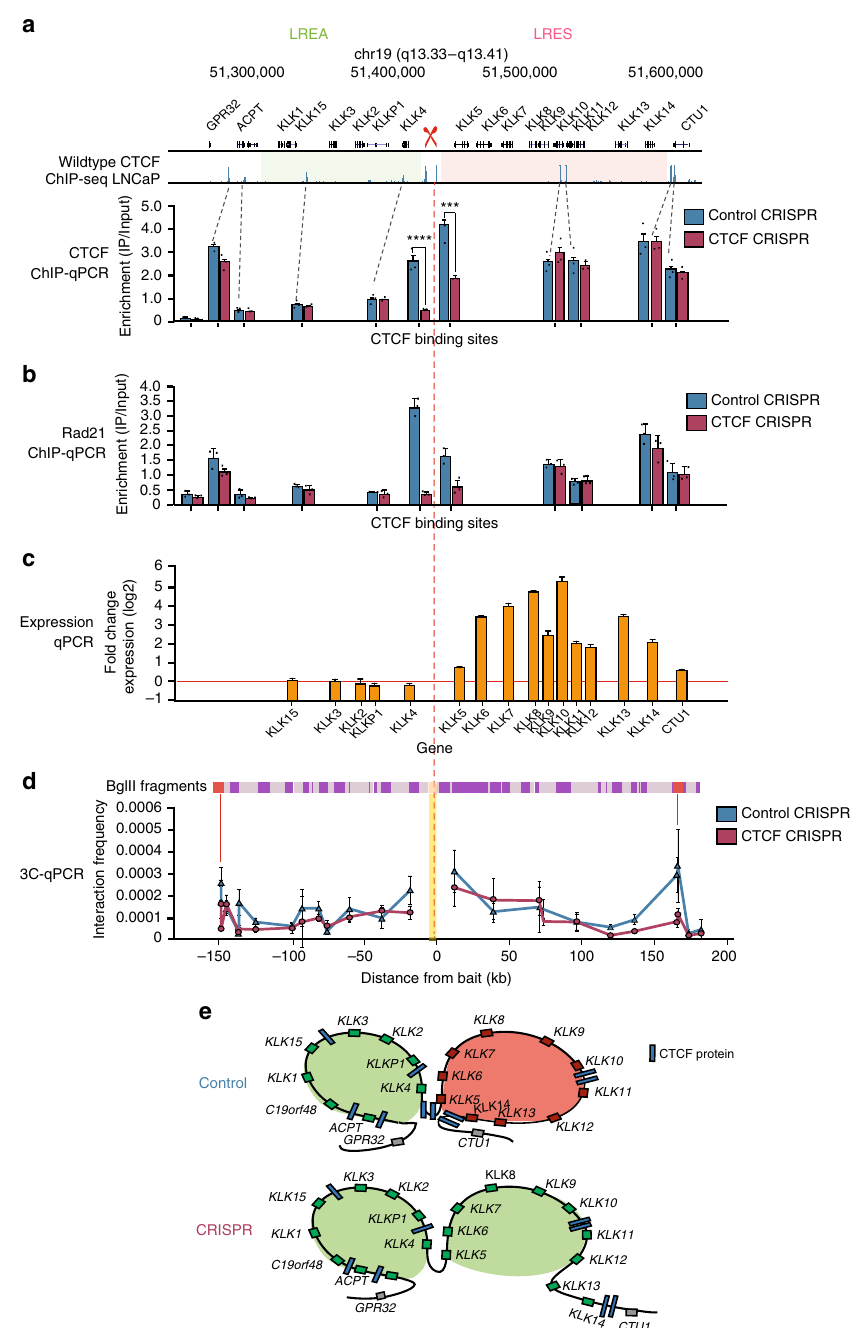
Fig. 5 CRISPR of persistent CTCF sites results in coordinate up-regulation of LRES genes. a CTCF ChIP-qPCR assaying all CTCF-binding sites at KLK locus was performed on control and CRISPR cells and demonstrates reduction of CTCF binding at CRISPR sites but retained binding at all other CTCF sites in the region (* indicates where two-tailed t -test, p < 0.001; n = 2 biologically independent experiments). Source data are provided as a Source Data fi le. Error bars represent SE. Data for technical replicates n = 3 are overlaid as a dot blot. b RAD21 ChIP-qPCR performed after CRISPR of persistent sites shows that cohesin binding is maintained at persistent sites but depleted across the other CTCF sites in the region. Error bars represent SE. Data for technical replicates n = 3 are overlaid as a dot blot. Source data are provided as a Source Data fi le. c qPCR for KLK gene expression following CRISPR of two persistent sites at the KLK locus shows coordinate up regulation of previously silenced genes. Error bars represent SE. Source data are provided as a Source Data fi le. d Biological replicate #1 of 3C-qPCR at the KLK locus following CRISPR of persistent sites shows changes to looping intensity between the bait fragment (yellow bar) and its upstream and downstream interacting fragments (red lines). Bars above the graph illustrate BglII fragments across the region. Error bars represent SE between technical replicates ((x3); see Supplementary Fig. 6a). e Schematic representation of data in d demonstrates the weakening of interaction between the bait and the downstream anchor point and expression of the normally silenced genes in the LRES region following CRISPR of CTCF-persistent